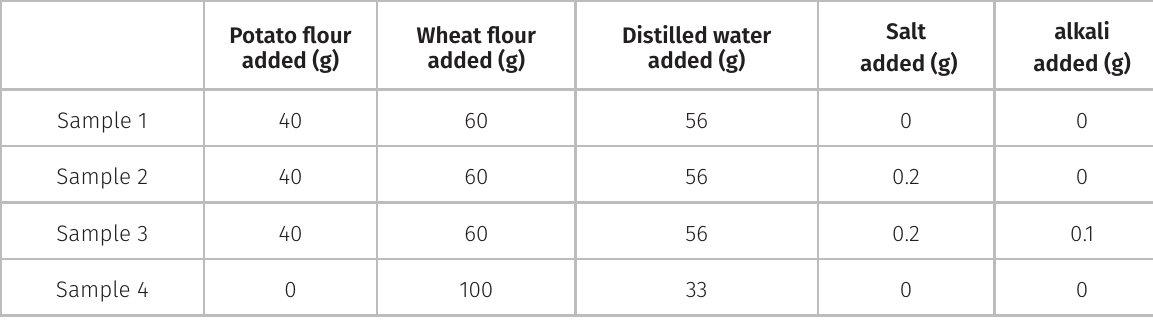
Table I. Sample information of four varieties of fresh wet noodle